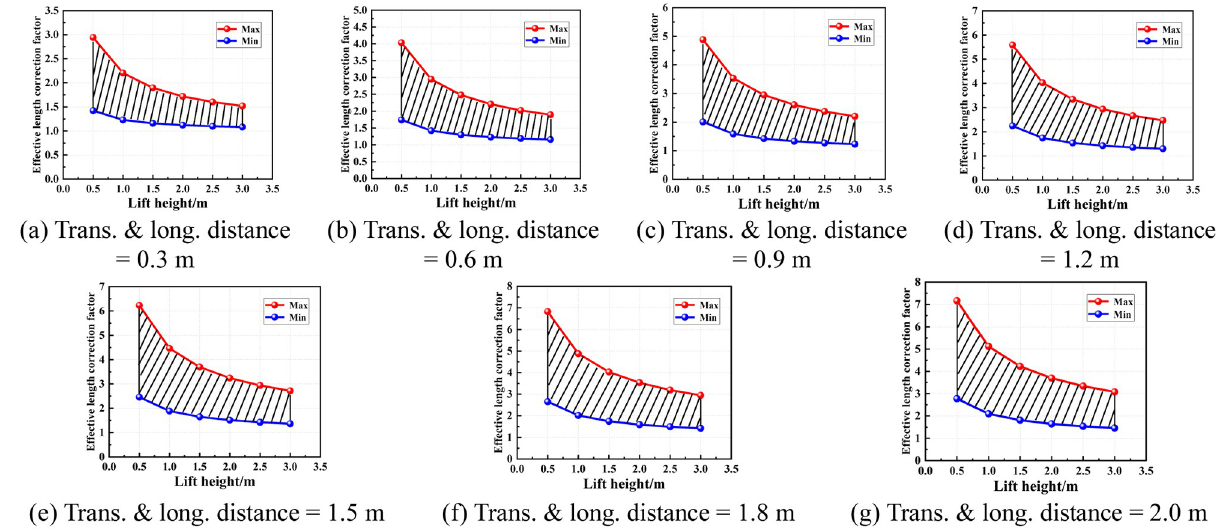
Fig 19. Value areas of the effective length correction factor of condition 4. (a) Trans. & long. distance = 0.3 m. (b) Trans. & long. Distance = 0.6 m. (c) Trans. & long. distance = 0.9 m. (d) Trans. & long. distance = 1.2 m. (e) Trans. & long. distance = 1.5 m. (f) Trans. & long. Distance = 1.8 m. (g) Trans. & long. distance = 2.0 m.